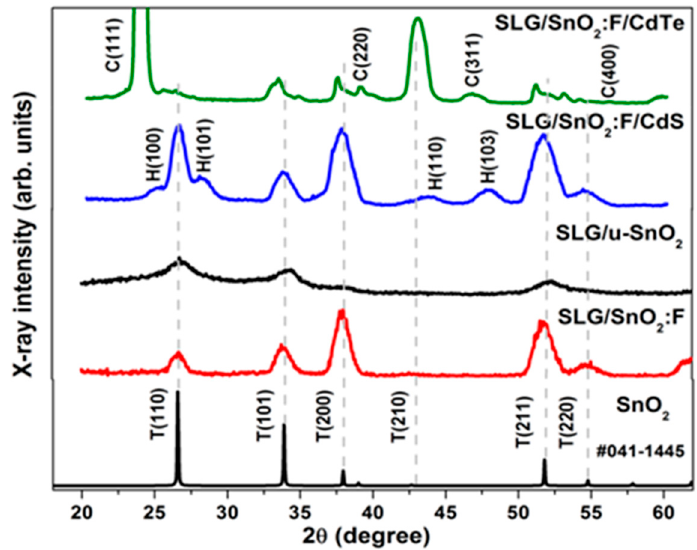
Figure 3. XRD pattern for SnO 2 , CdS, and CdTe deposited onto TEC15. T, C and H stand for tetragonal, cubic, and hexagonal phases.